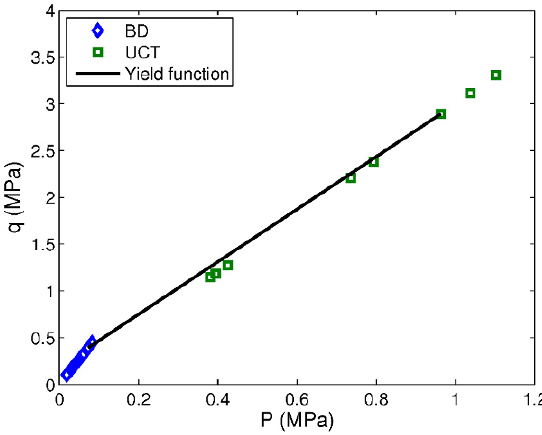
Figure 7. Yield function for sandy gravel. Measurements with Brazilian Disc (BD) and Unconfined Compression Test (UCT) are shown, where the yield function represents the Drucker-Prager line with 0.9% average moisture content and ρ = 2234 kg/m 3